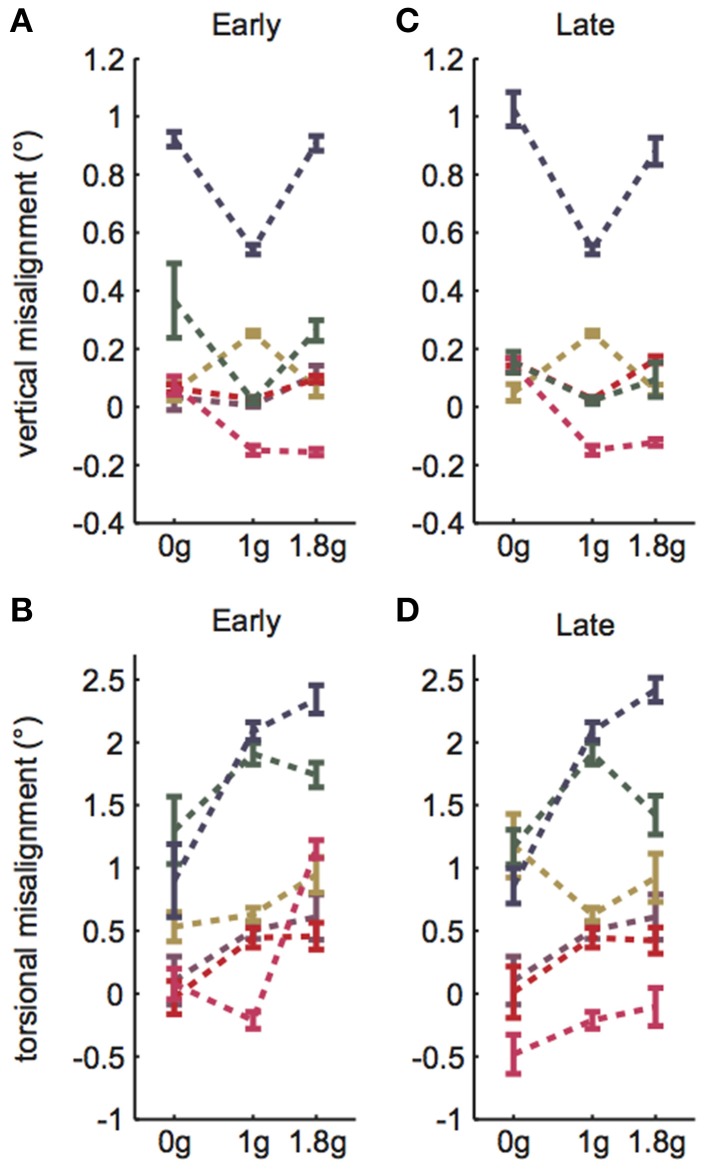
VAN and TAN parabolic flight results. (A)
Early VAN data was collected during parabolas 6–10. (B)
Early TAN data was collected during parabolas 1–5. (C)
Late VAN data was collected during parabolas 26–30. One subject was not tested during these parabolas. (D)
Late TAN data was collected during parabolas 21–25. Dashed lines simply group data within subjects and do not represent actual (or proposed) g-level responses. Error bars are ±1SE.